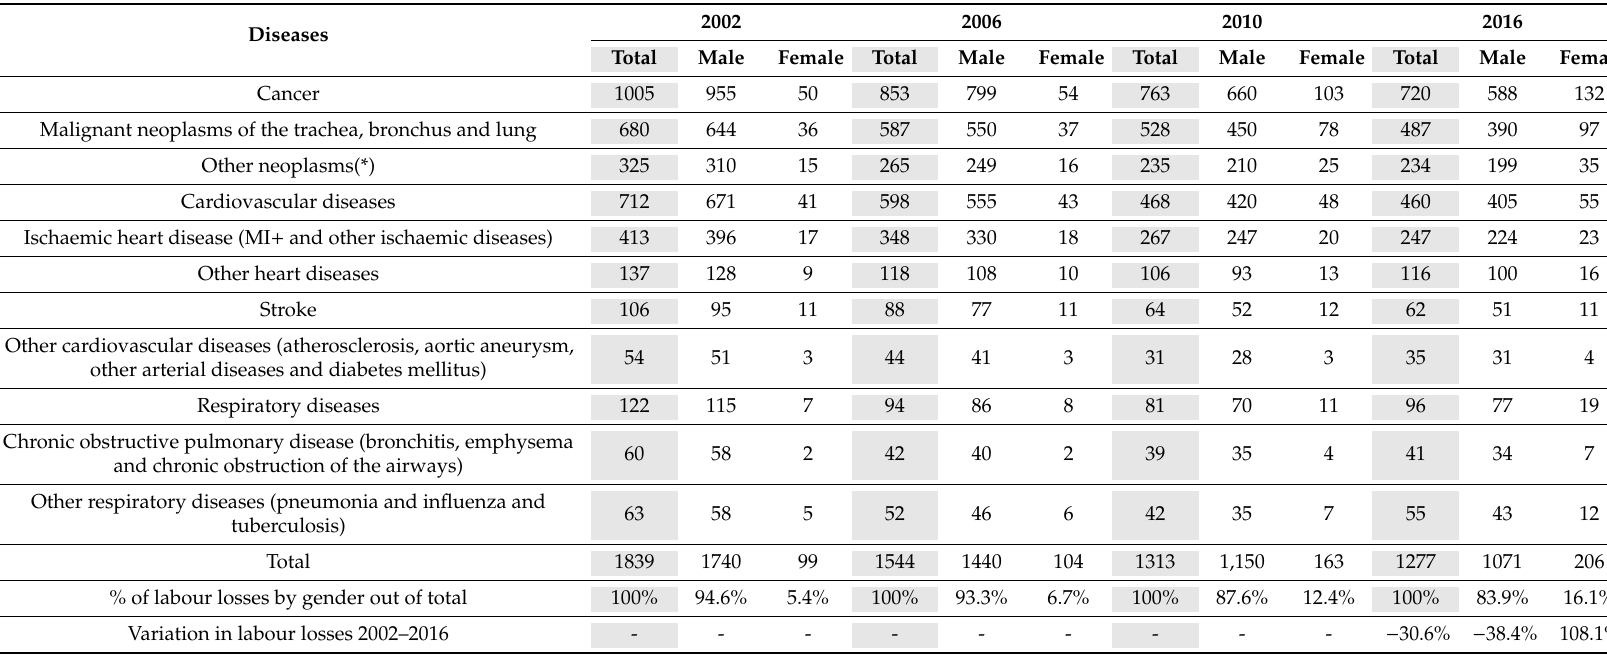
Table A6. Sensitivity analysis l. Labour losses (constant 2016 euros) (millions of euros). Annual discount rate 6%. Annual labour productivity growth rate